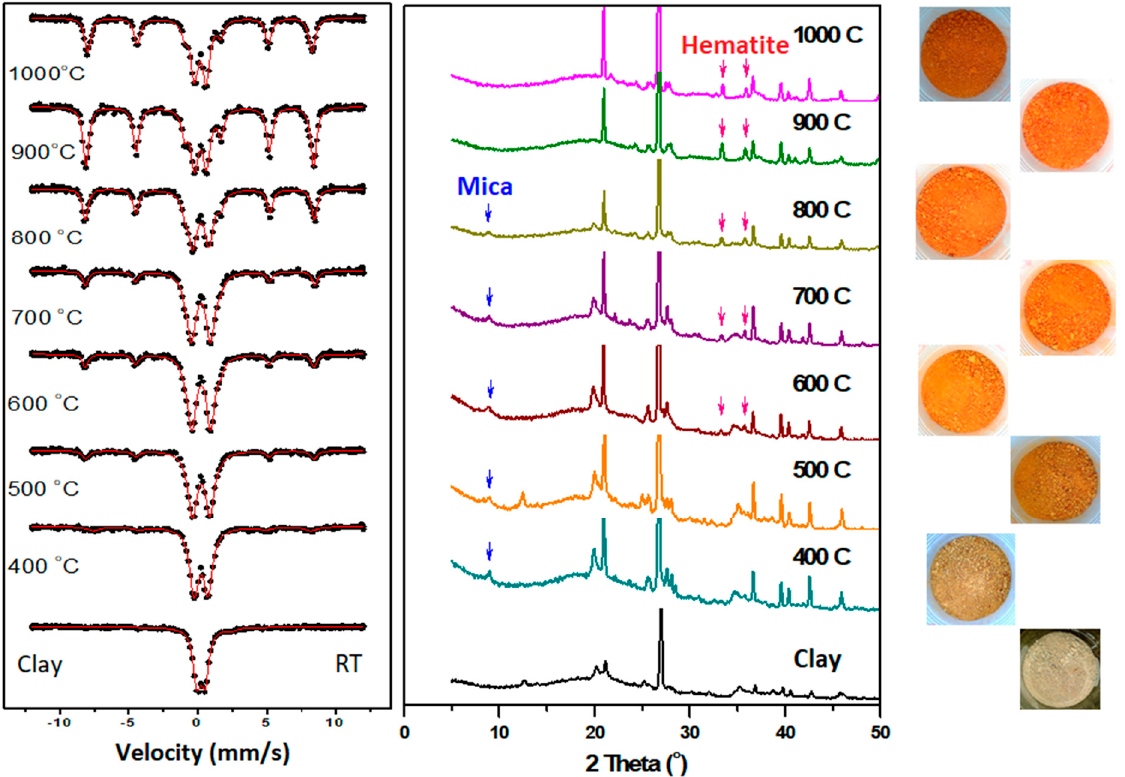
Figure 7. Mössbauer and XRD spectra of clay fired from 400 °C to 1000 °C.